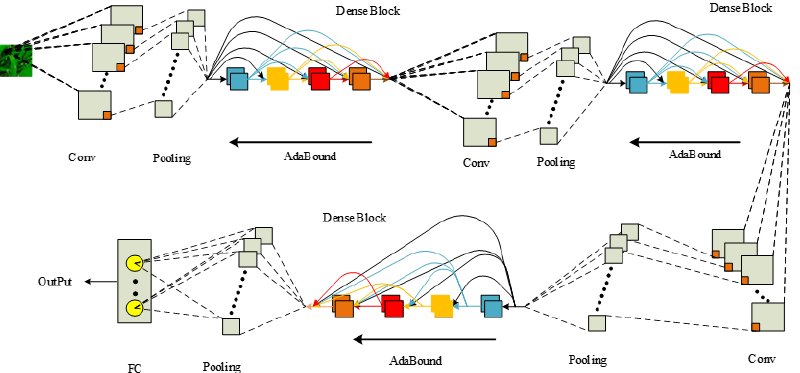
Figure 5. AB-SE-DenseNet model architecture. The variants of the AB-SE-DenseNet network are all based on the three SE-DenseNet networks shown in Figure 4.